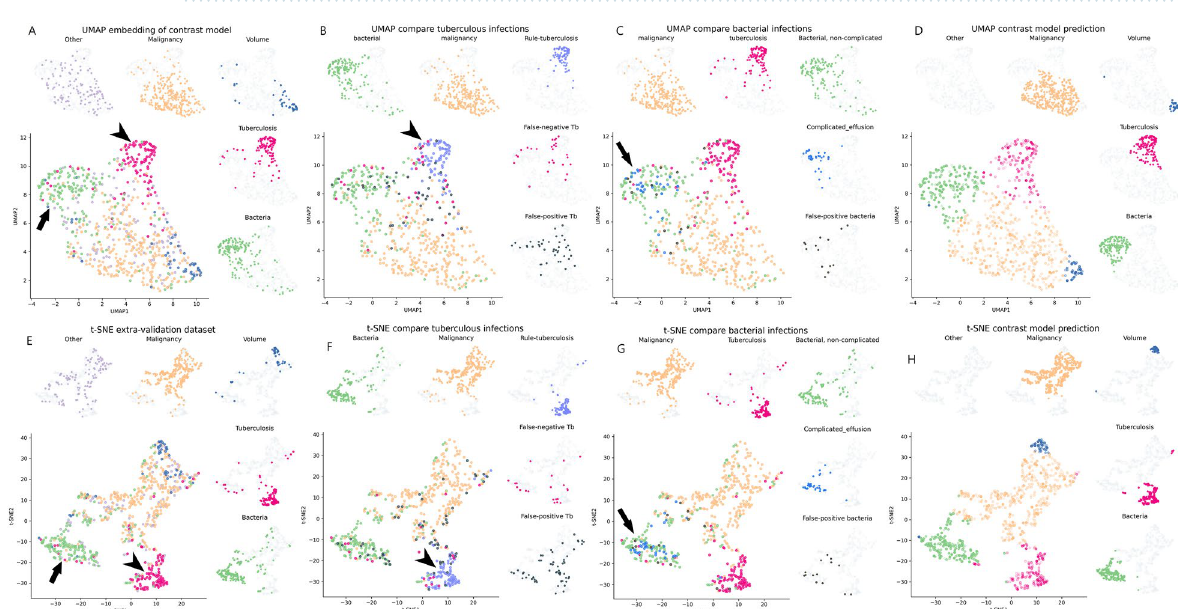
Figure 5. Comparison of the contrastive-loss model prediction with the rule-based label in the extra-validation set. Rule-tuberculosis: true-positive of the rule-based tuberculosis criteria; Rule-complicated effusion: true- positive of the rule-based complicated effusion. Arrowhead indicates the embedding area of tuberculosis in UMAP ( A, B ) and t-SNE ( E, F ), and many true-positive of rule-based tuberculosis is located in the tuberculosis area. The arrow indicates the embedding area of bacterial infection, and the blue (complicated effusion) is located at the center of the bacterial infection area. ( A, C, E, G ) The predicted probability of the contrastive-loss model is visualized according to each etiology, in which a higher density indicates higher prediction probability. ( D , H